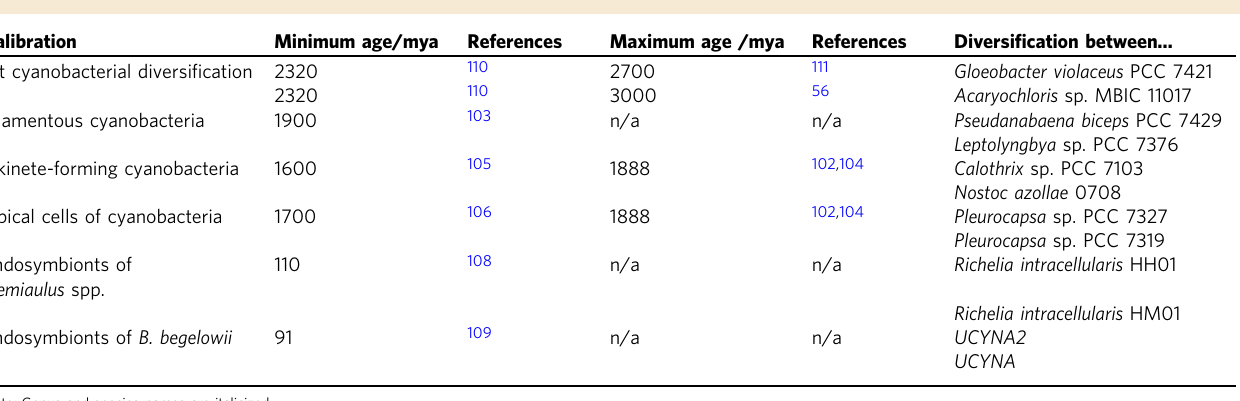
Table 1 Calibration points used for molecular clock analyses. Calibration